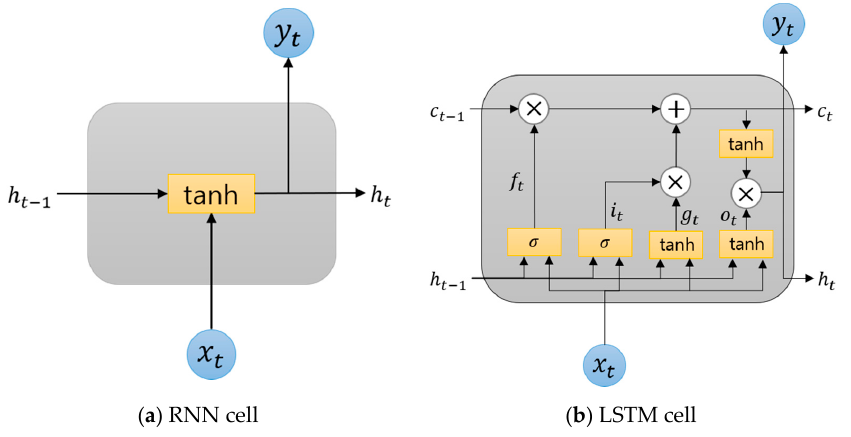
Figure 1. ( a ) The Architecture of Recurrent Neural Network (RNN) cell; ( b ) The Architecture of Long Short-term Memory (LSTM) cell. Short-term Memory (LSTM)